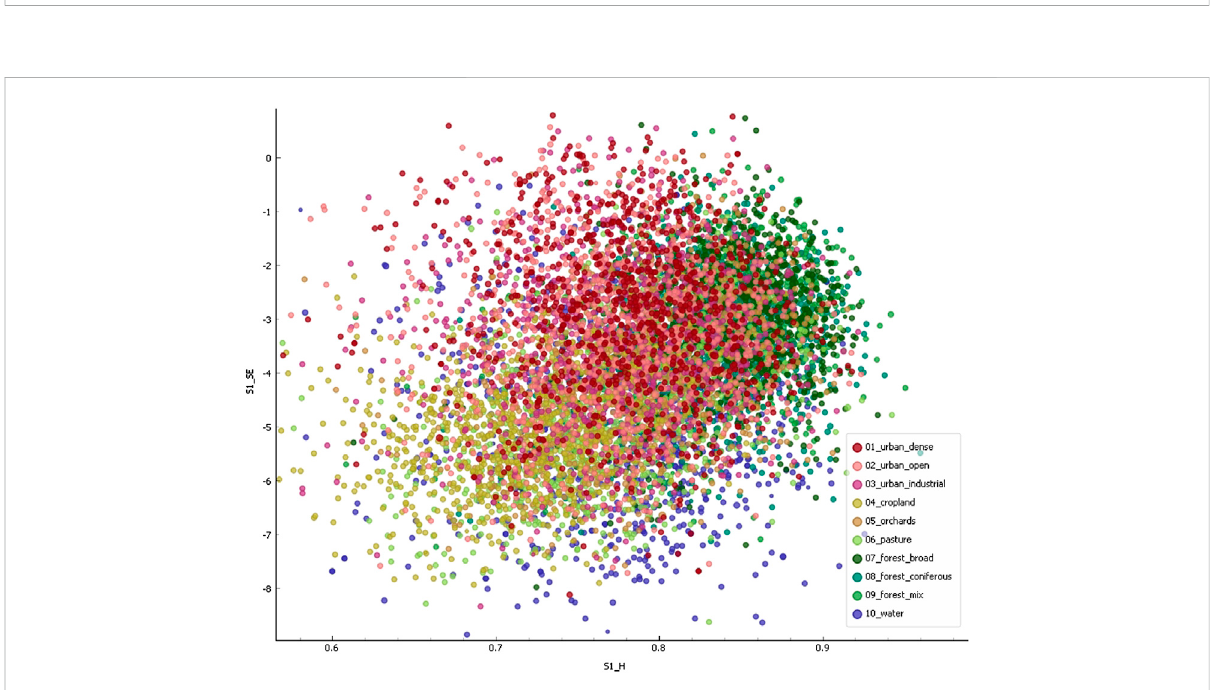
FIGURE 11 ScatterplotbetweenpolarimetricEntropy(x)andShannon Entropy(y)retrievedfromSentinel-1pseudo-polarimetricdata.Colors indicateland use and land cover classes as de fi ned in Table